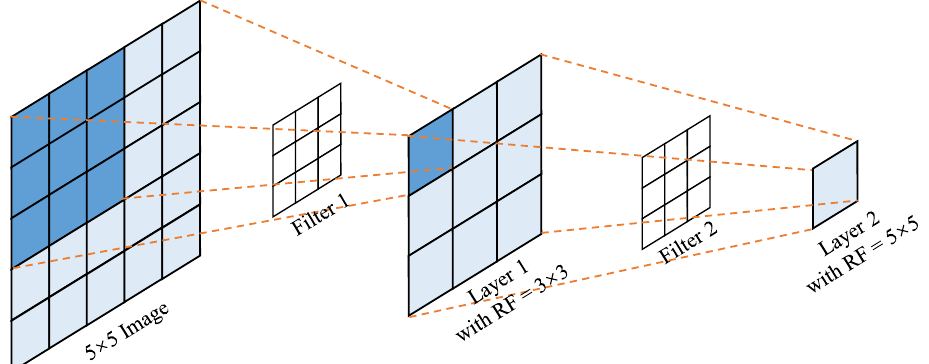
Figure 2. The receptive fields of CNNs in different layers. As the convolution proceeds, the range of receptive fields gradually increases. Layer 1 gets an RF of 3 × 3 (blue area in the image), while 5 × 5 for layer 2 (light blue area in the image). Note that the two filters are both fixed at testing. However, the learned convolutional filters are fixed at testing, which hinders the generalization of CNNs. To make the model more adaptive and general, vision Transform- ers [5–8] bring the self-attention mechanism from natural language processing to computer vision. The self-attention mechanism is illustrated in Figure 3. The fixed convolutional filters are replaced with weights that can be computed dynamically based on the similarity or affinity between every pair of patches, thus enabling capturing “long-term” information and dependencies between sequence elements. Therefore, vision Transformers have a larger receptive field to extract finer features at the encoding stage.